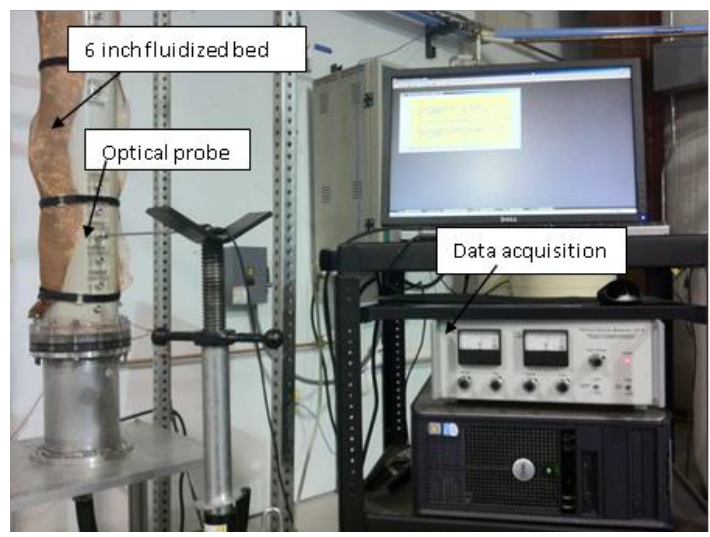
Figure 9. Fiber optic probe (PV6) mounted on a 0.14 m inner diameter fluidized bed.